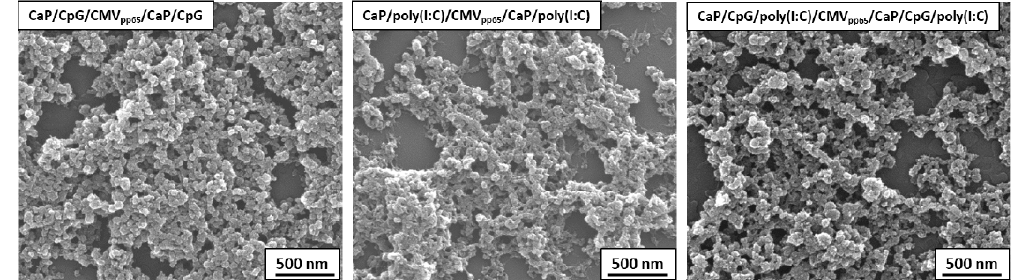
Figure 1. Scanning electron micrographs of functionalized calcium phosphate (CaP) nanoparticles. Representative scanning electron microscopy (SEM) images of triple shell CaP nanoparticles (NPs)